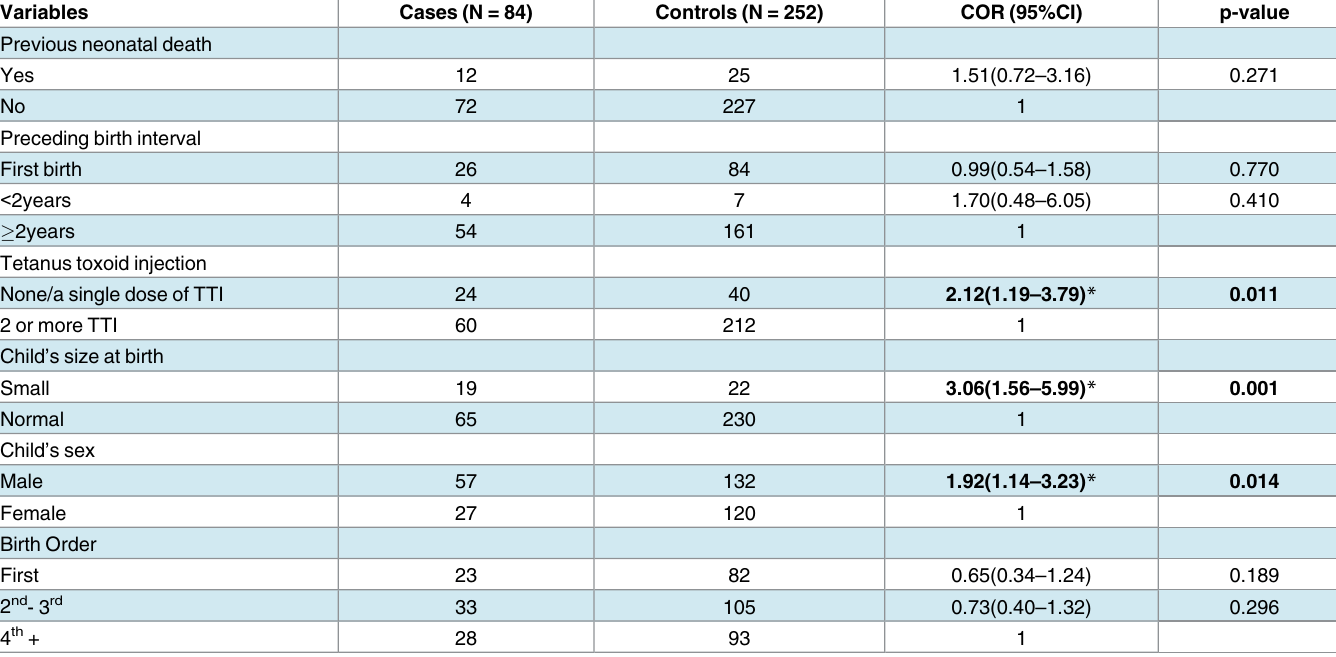
Table 2. Bivariate logistic regression analysis depicting the association between independent variables and neonatal mortality in North Shoa Zone of Amhara Regional State, 2014.